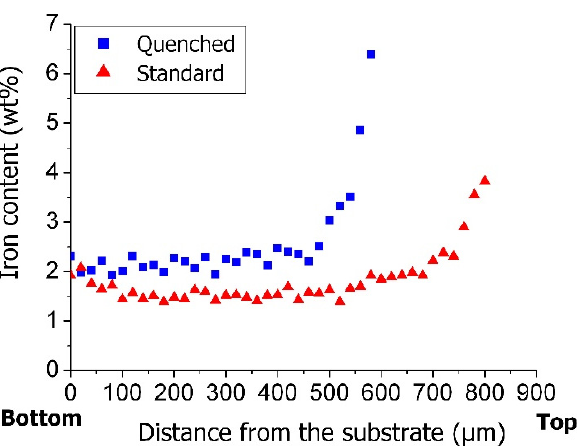
Figure 3 . WDS profiles of iron content along the cross-section of VACNT carpets from the top to the base (substrates) for samples coming from ( ■ ) quenched and ( ▲ ) standard cooling procedures, re- spectively.